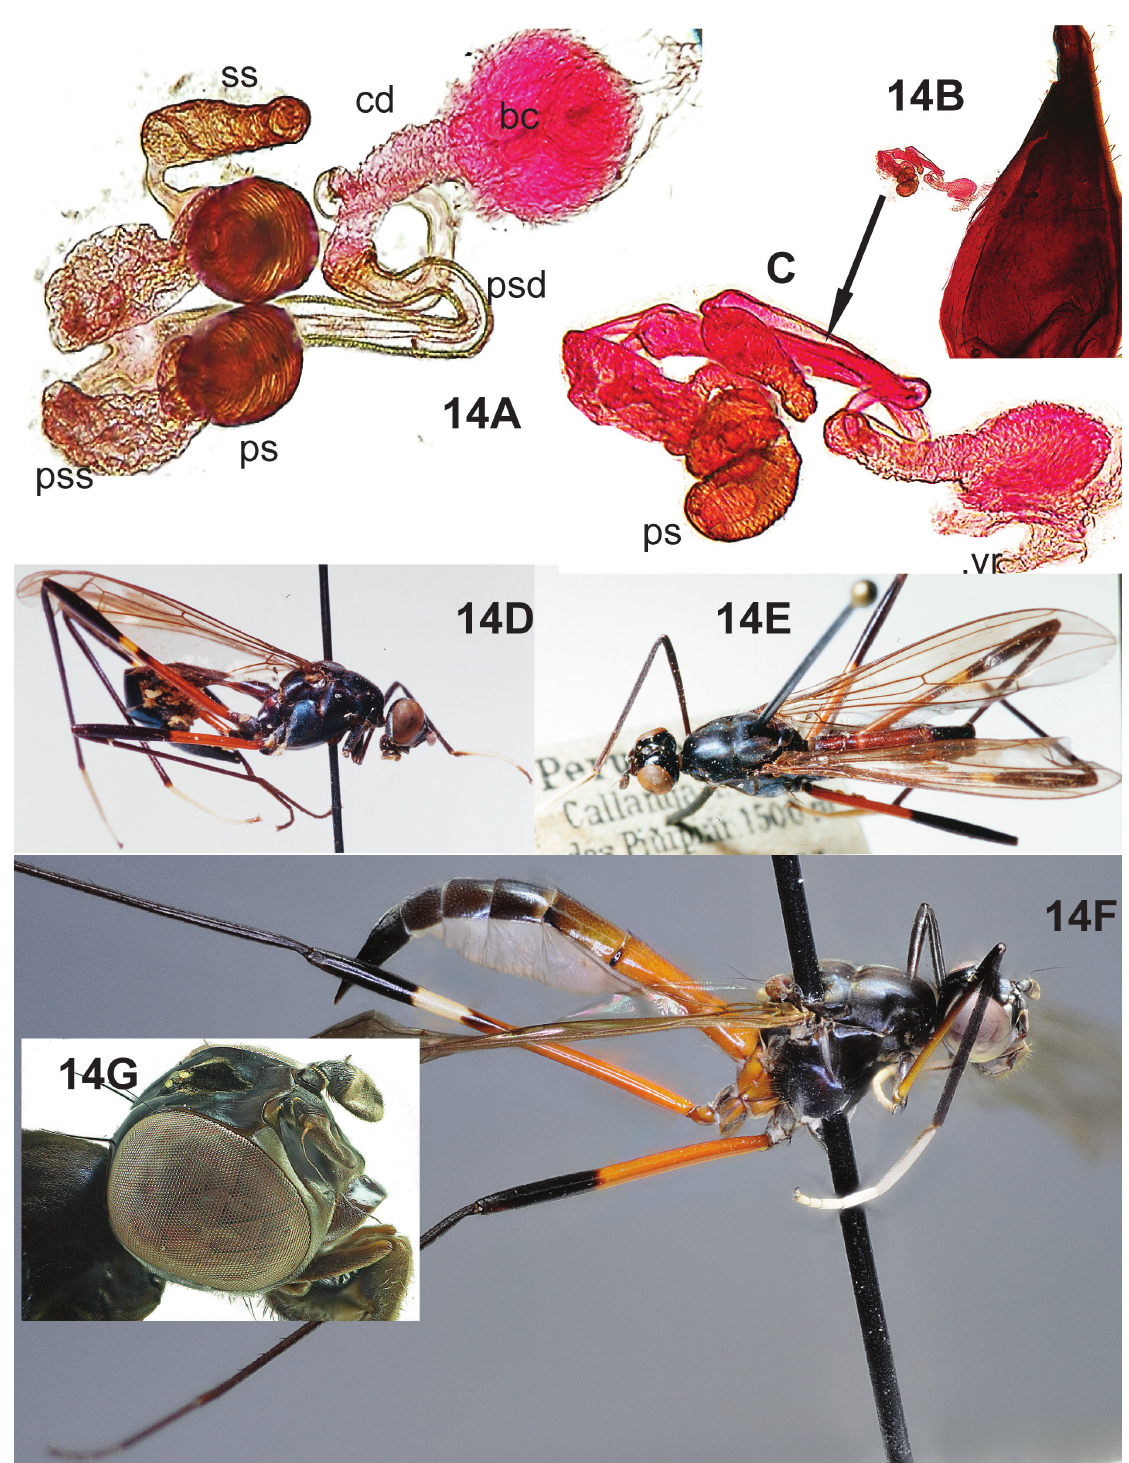
Fig. 14. Mesoconius obtusiconus Enderlein, 1922, ♀♀. A . Spermathecae and associated structures, dorsal view, Colombia. B . Oviscape with spermathecae teased out, Colombia. C . Spermathecae and associated structures, lateral view, Colombia. D–E . Holotype, MNBG, Peru. F . Entire specimen, Colombia. G . Head, Colombia. Abbreviations: bc = bursa copulatrix; cd = common duct; ps = paired spermatheca; psd = paired spermathecal duct; pss = paired spermathecal stem; ss = single spermatheca; vr = ventral